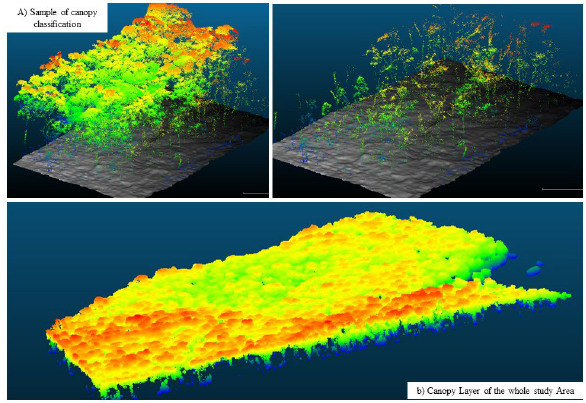
Figure 14: a) Sample of canopy classification b) Canopy layer